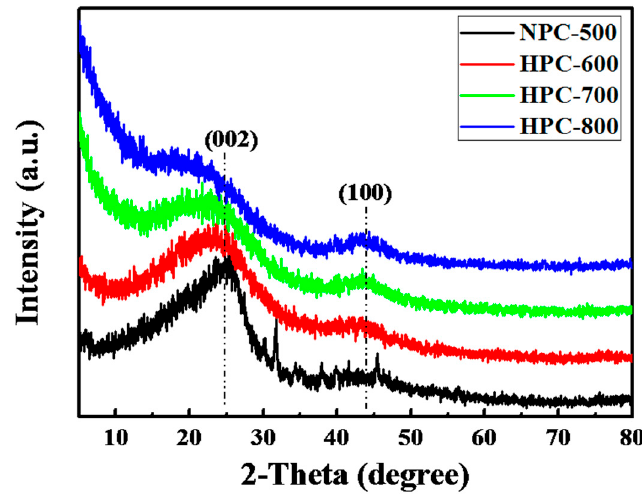
Figure 2. X-ray Diffraction (XRD) patterns of the NPC-500, HPC-600, HPC-700, and HPC-800.